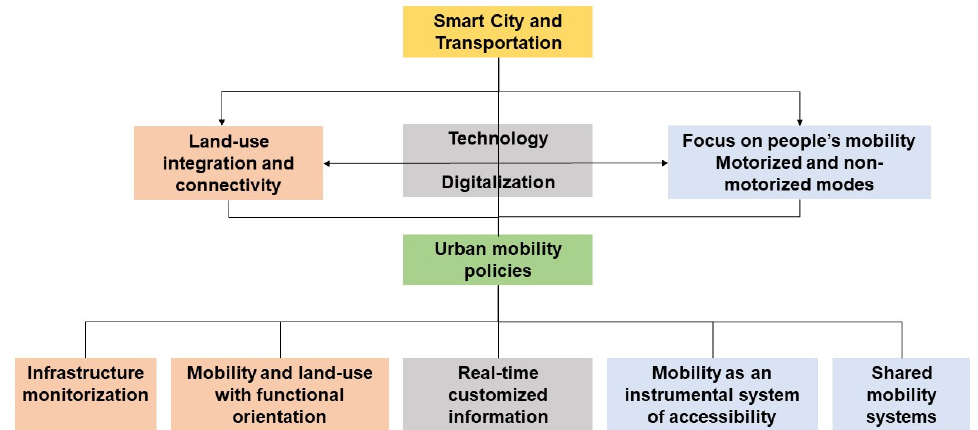
Figure 3. New approach to urban mobility policy. Source: Authors.